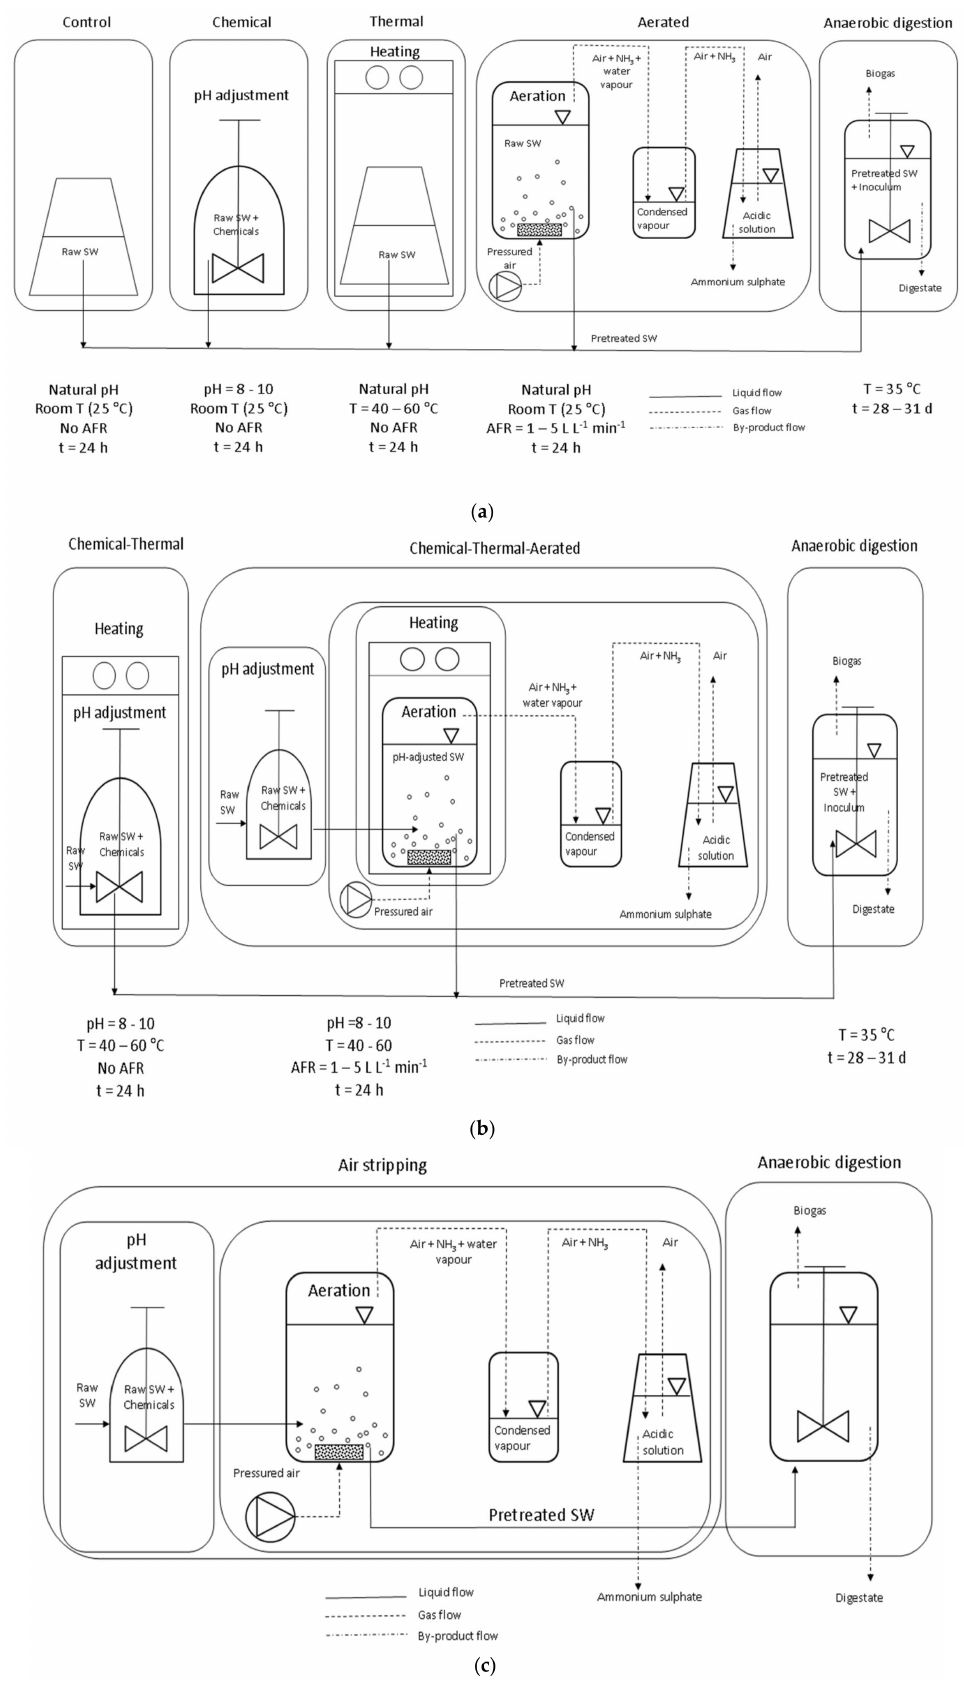
Figure 1. Experimental design of the systems treating swine wastewater (SW): ( a ) individual treatments, ( b ) combined treatments, and ( c ) air stripping and anaerobic